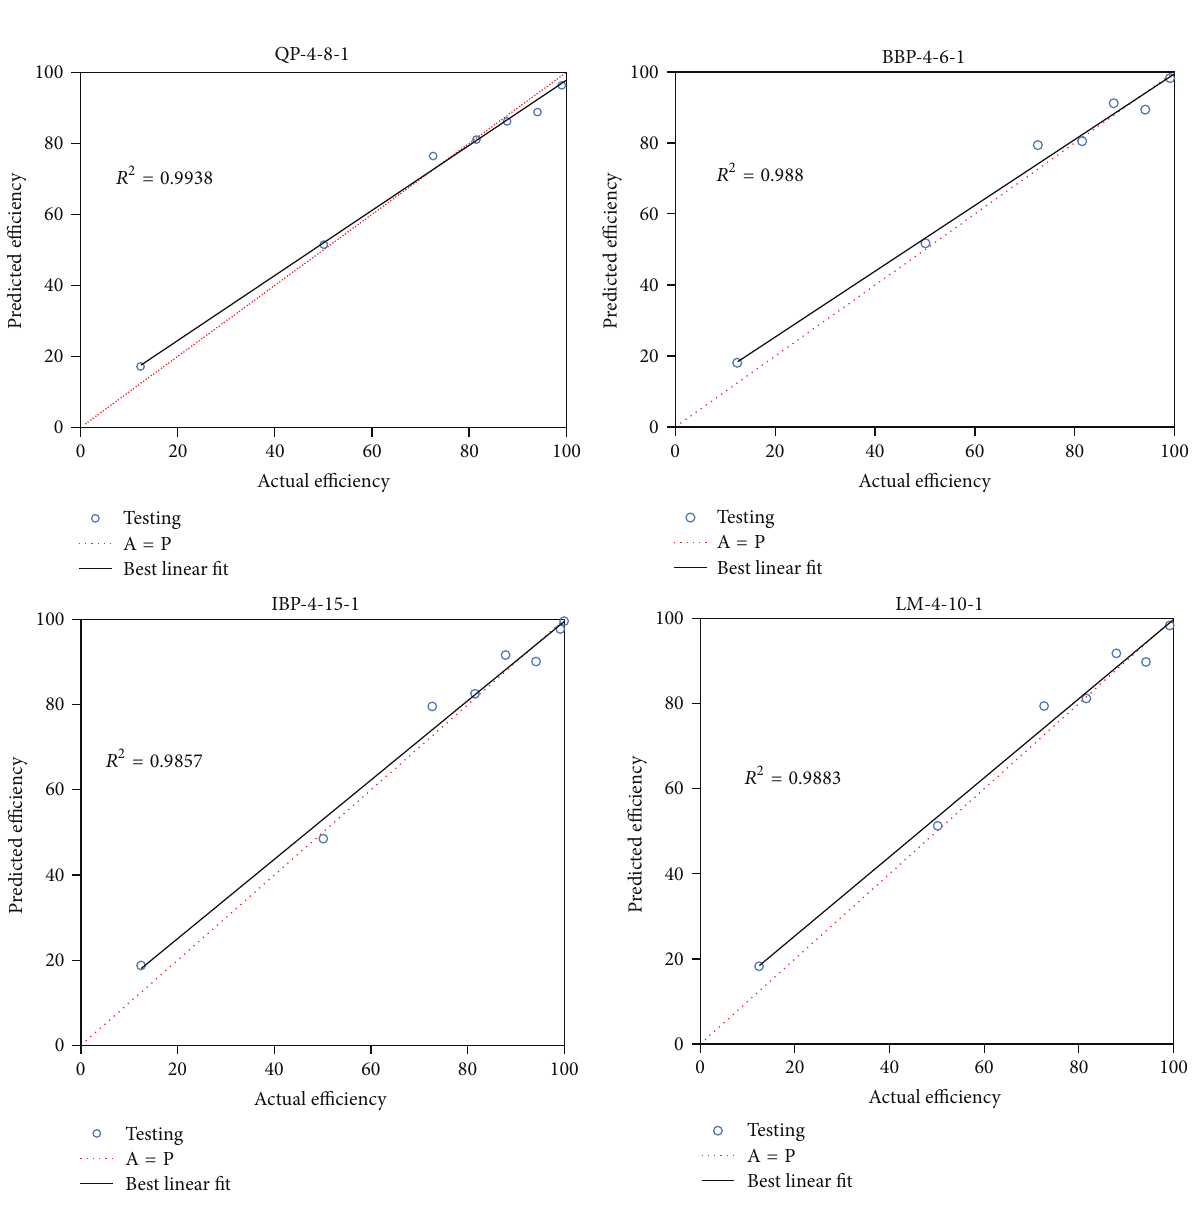
Figure 2: The scatter plots of the predicted efficiency versus actual efficiency for testing data set that shows the performed 𝑅 2 of optimized topologies, QP-4-8-1, BBP-4-6-1, IBP-4-15-1, and